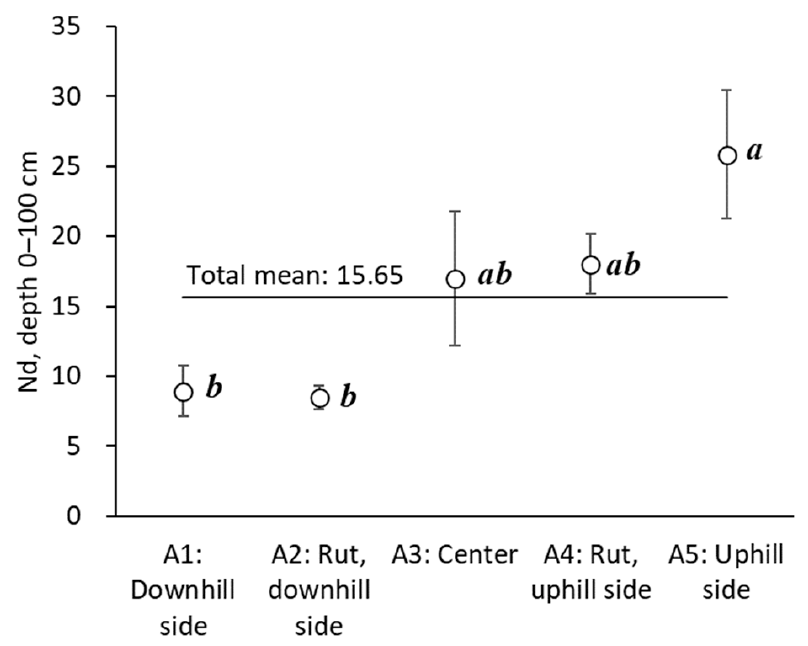
Figure 9. Main effect of Factor A, relative position within the road width, of Site 1 on the N d -value. The error bars represent the standard error (SE). Different letters indicate significant differences between the population means. Tukey test, p < 0.01, n = 24.